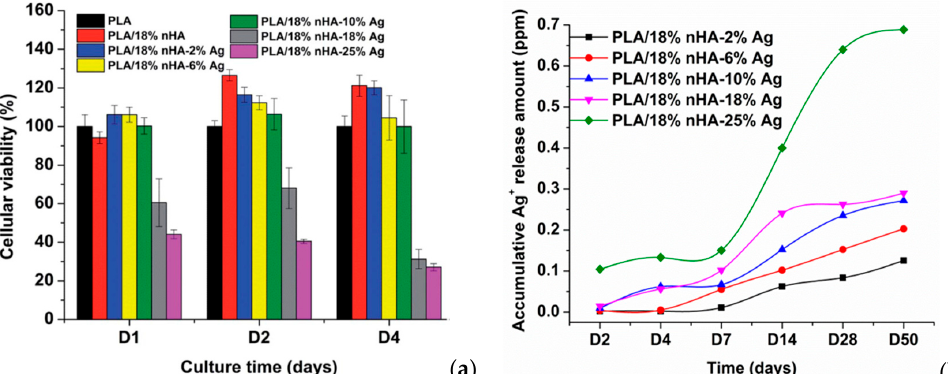
Figure 8. ( a ) Viability of osteoblasts cultured on PLA and its nanocomposites for 1, 2 and 4 days; error bars denoted standard deviations. ( b ) Released Ag + ion vs. time plots of PLA/18 wt% nHA–AgNPs hybrids immersed in distilled water at 37 °C. The concentration of silver ions was determined with inductively coupled plasma atomic emission spectrometry. Reproduced with permission from [154], Copyright Royal Society of Chemistry, 2015.